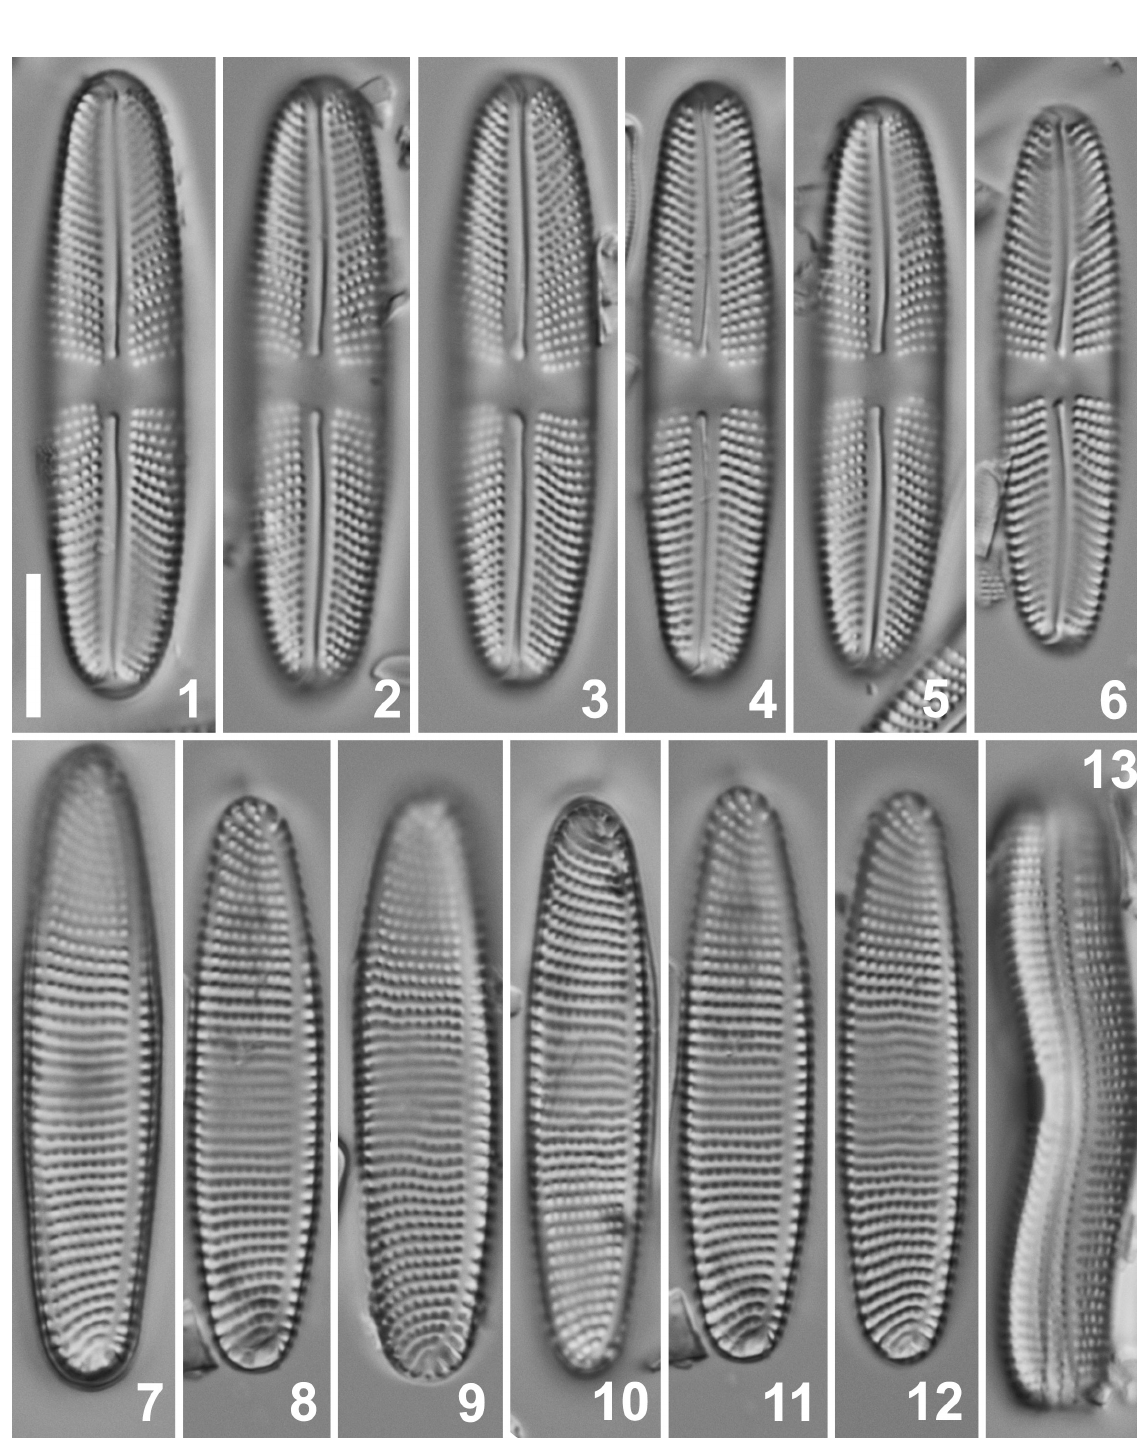
Figs 1–13. Achnanthes kohleriana Kopalová, Zidarova & Van de Vijver sp. nov. Light micrographs of the type population from Deception Island (South Shetland Islands, Antarctica). 1–16 . LM views of raphe valves. 7–12 . LM views of rapheless valves. 13 . LM view of a girdle view. Scale bar represents 10